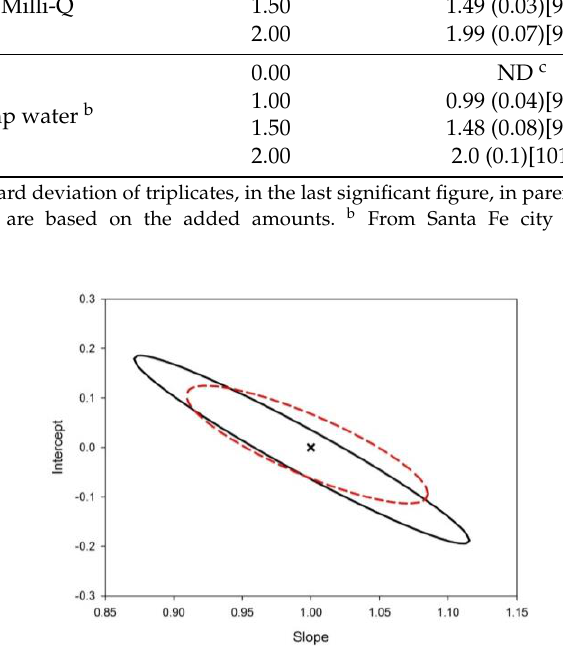
Figure 5. Elliptical joint confidence regions for the slope (b) and intercept (a) corresponding to a linear regression of nominal concentrations of accuracy samples vs. Hg 2+ concentrations found for each analyzed matrix, i.e., Milli-Q water (black solid line) and tap water (red dashed line). The black cross indicates the theoretical point (a = 0, b = 1).